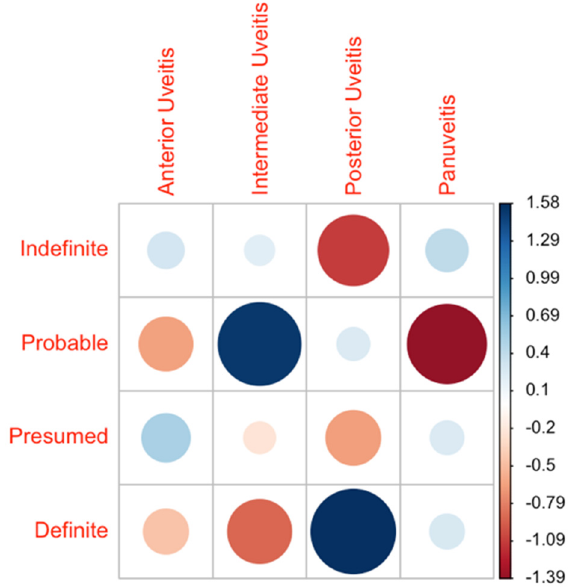
Figure 1. Distribution of uveitis forms across the diagnostic groups. The data are presented as a correlation matrix. The blue color represents a higher-than-expected probability of occurrence, and red represents a lower probability. The larger the circles, the higher the deviation from the expected value given a homogeneous distribution across all groups.